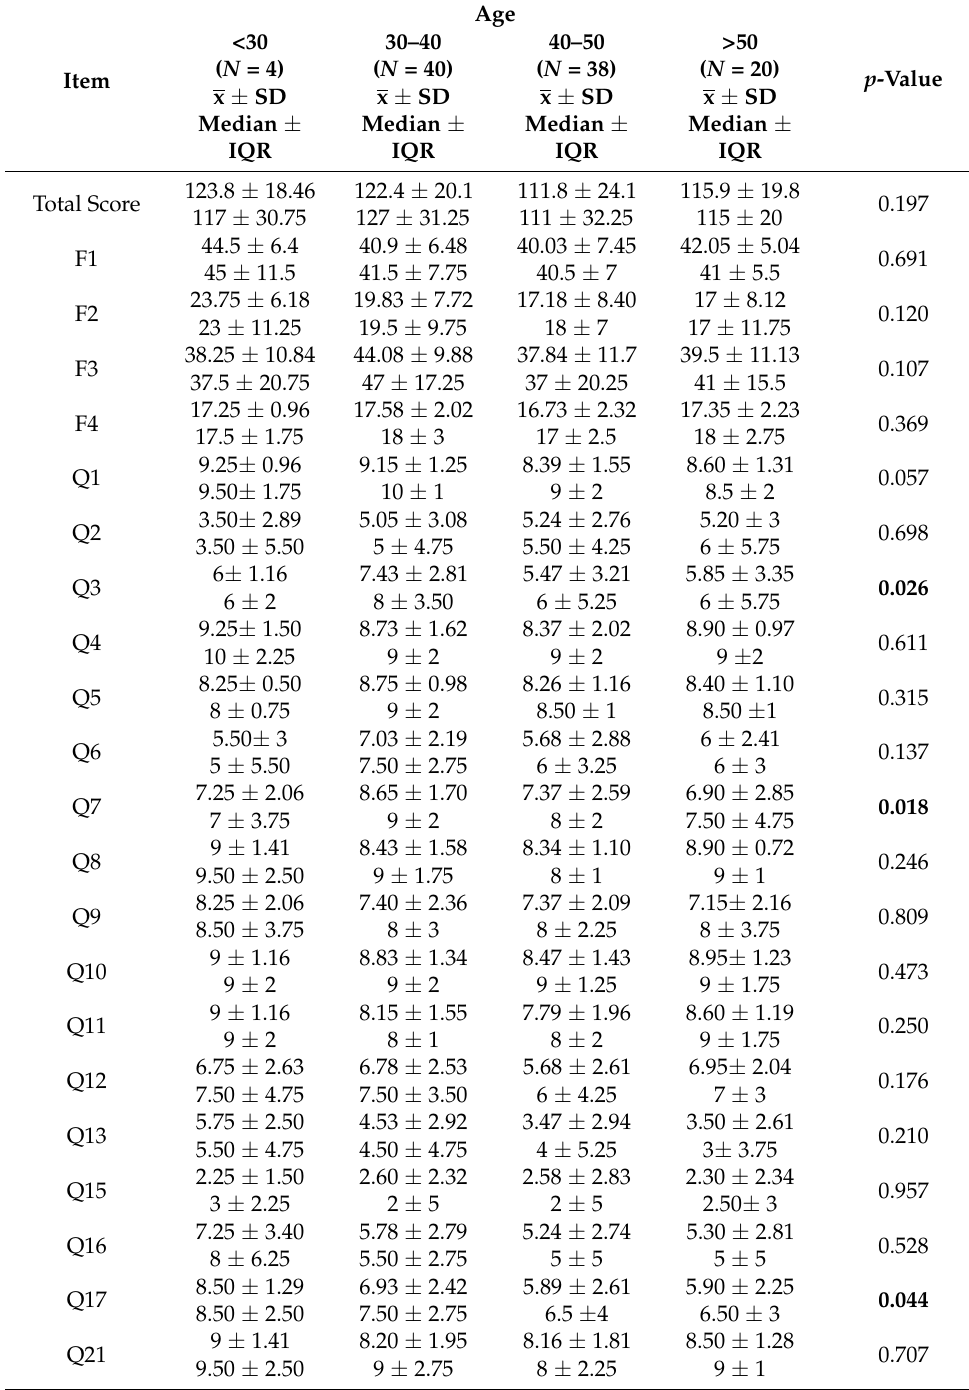
Table 7. Comparison by age for each item in the